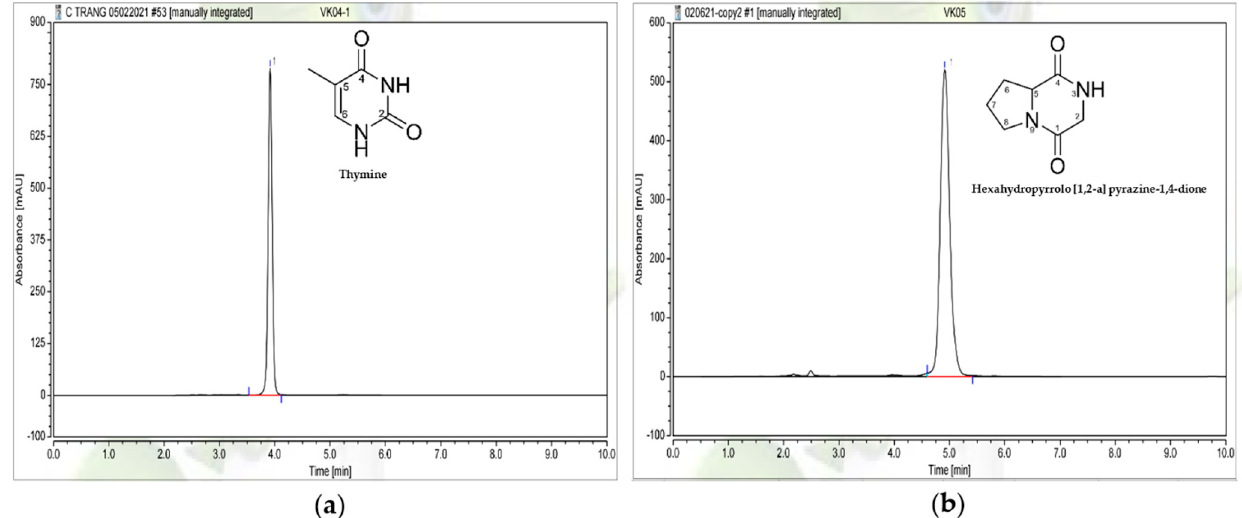
Figure 2. The HPLC profiles of the two antinematode compounds, including thymine ( a ) and hexahydropyrrolo [1,2-a] pyrazine − 1,4 − dione ( b ) purified and identified in this study.